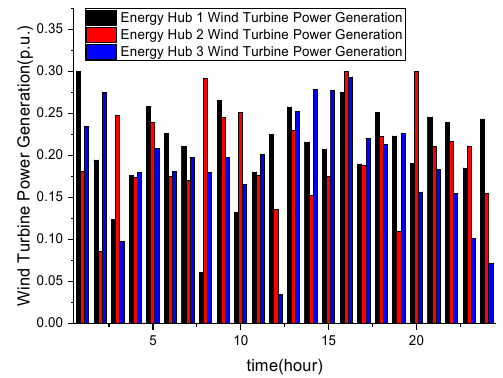
Figure 4. Simulated electrical load and heat load.